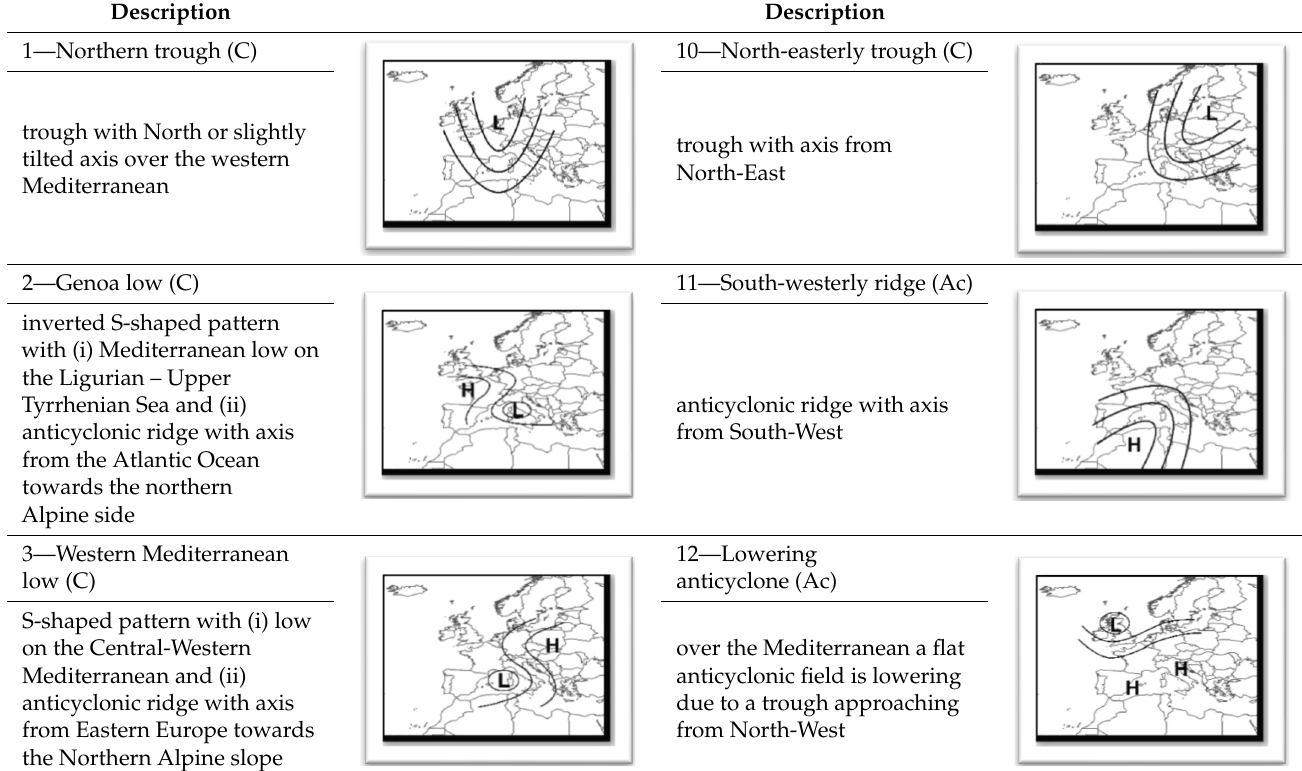
Table 1. CWT classification (C = cyclonic, Ac = anticyclonic, I = intermediate).